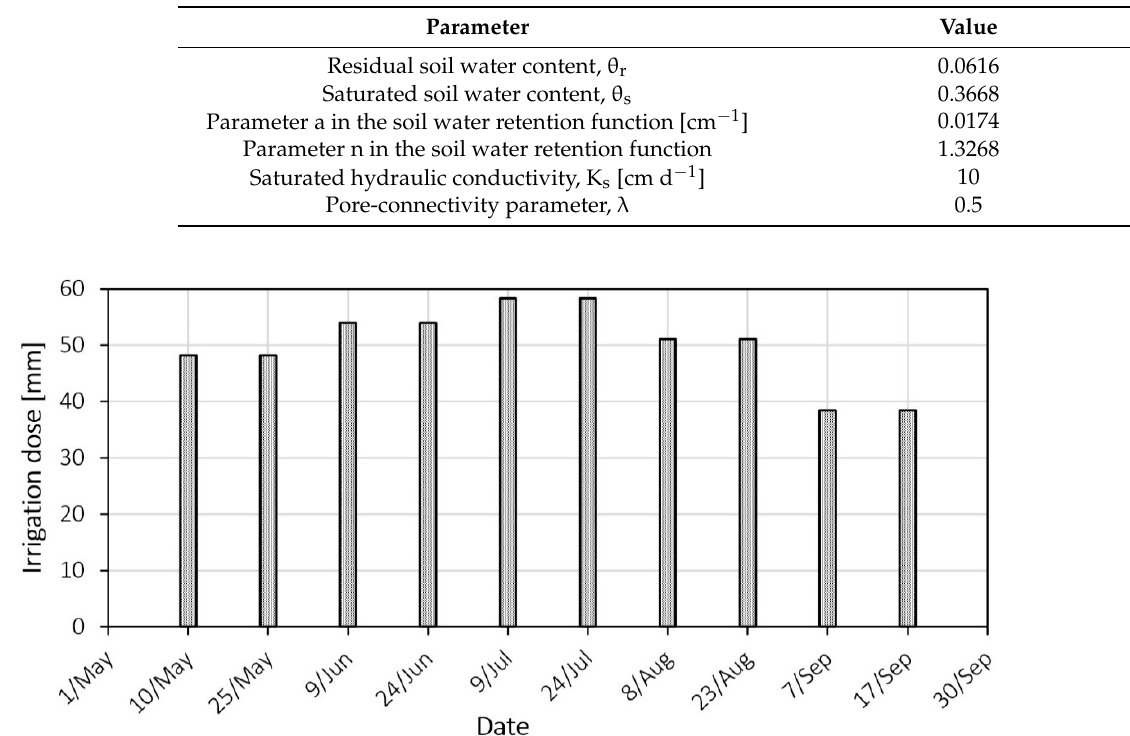
Figure 1. Ions/nutrients release from the soil/biochar mixture. Table 4. Soil hydraulic parameters (van Genuchten parameters and saturated hydraulic conductivity). Table 3. Main physicochemical characteristics of the irrigation water.